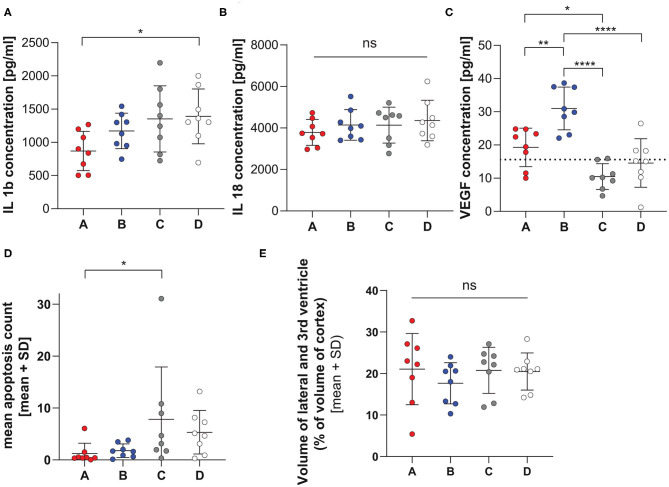
Inflammatory and histological parameters in infection with single RMS allele variant. Cytokine levels of IL-1β (A), IL-18 (B), and VEGF (C) measured in cerebellum homogenate at 42 hpi in infant rats infected with the 4 different hsdS allele variants (A: n = 8, B: n = 8, C: n = 8, D: n = 8). The horizontal dotted line represents the lower limit of detection, data points under the line are extrapolated measurements. The variants show different concentrations for IL-1β and VEGF. Variant D leads to higher IL-1β level, whereas variant B shows elevated VEGF levels. No significance was found for IL-18 levels. Significant difference in the level of apoptosis (D) was only found for the comparison between infection with variants A and C, while hydrocephalus (E) was not different between infection with the 4 variants. *p < 0.05; **p < 0.01; ****p < 0.0001.